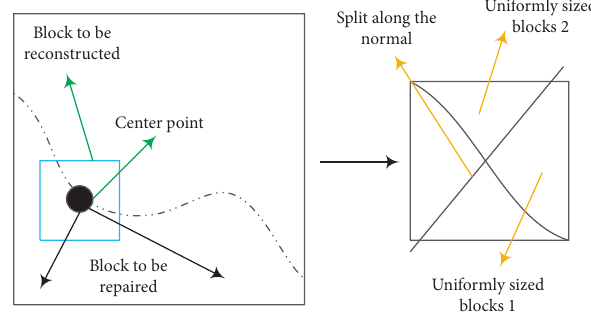
Figure 5: Calculation principle of edge discriminant factor.